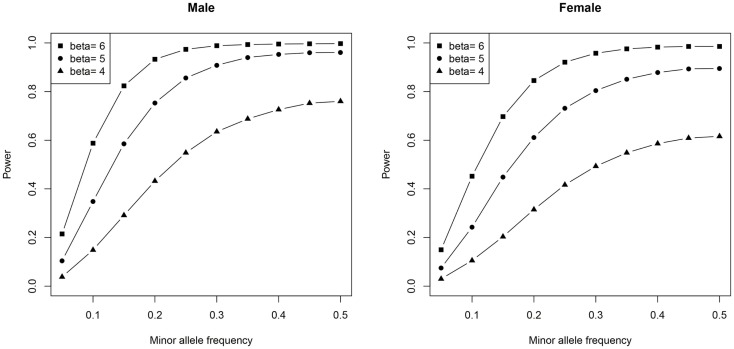
Plots demonstrating the relationship between statistical power, minor-allele frequencies, and effect size are shown.